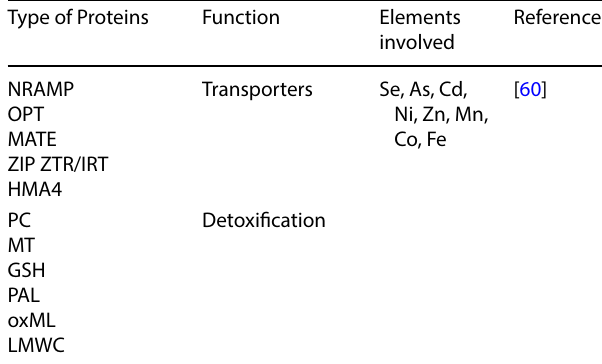
Table 1 Proteins involved in heavy metal tolerance and resistance in plants